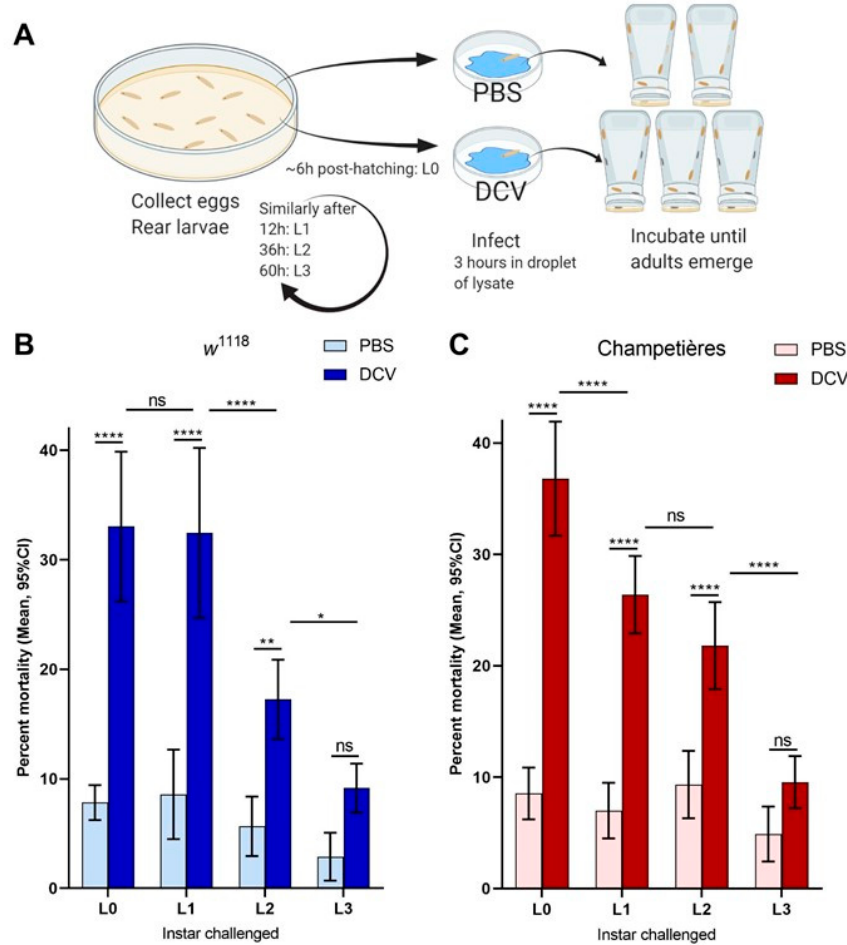
Figure 1. Mortality caused by DCV decreases when infection occurs later in larval development: larvae of the w 1118 and Champetières fly lines were picked from rearing plates and orally challenged with lysates of DCV- or PBS-injected flies at 4 different times post ecclosion, and transferred to individual test plates ( A ). At least 4 biological replicates were done, each containing 2-PBS- and 3-DCV-challenged groups of larvae, per time point. Mortality was calculated from the proportion of adults that emerged from the larvae transferred to each test plate, for each PBS or DCV feeding challenge. A two-way ANOVA analysis was used to compare the effect of infection and the time (of larval development) at which the challenge was done. Using Šídák’s test for multiple comparisons, the survival between PBS and DCV at each time point was compared, to determine that L0, L2, and L2 larvae were susceptible to lethal DCV infection compared to their uninfected controls; and Tukey’s test was used to compare the mortality after PBS or DCV feeding across instars, to determine that the mortality caused by DCV decreased significantly between the L0-L1, L1-L2, and/or L2-L3 times of infection (( B , C ); statistical analysis results are detailed in Table S1; * p < 0.05, ** p < 0.01, *** p < 0.001, **** p < 0.0001).